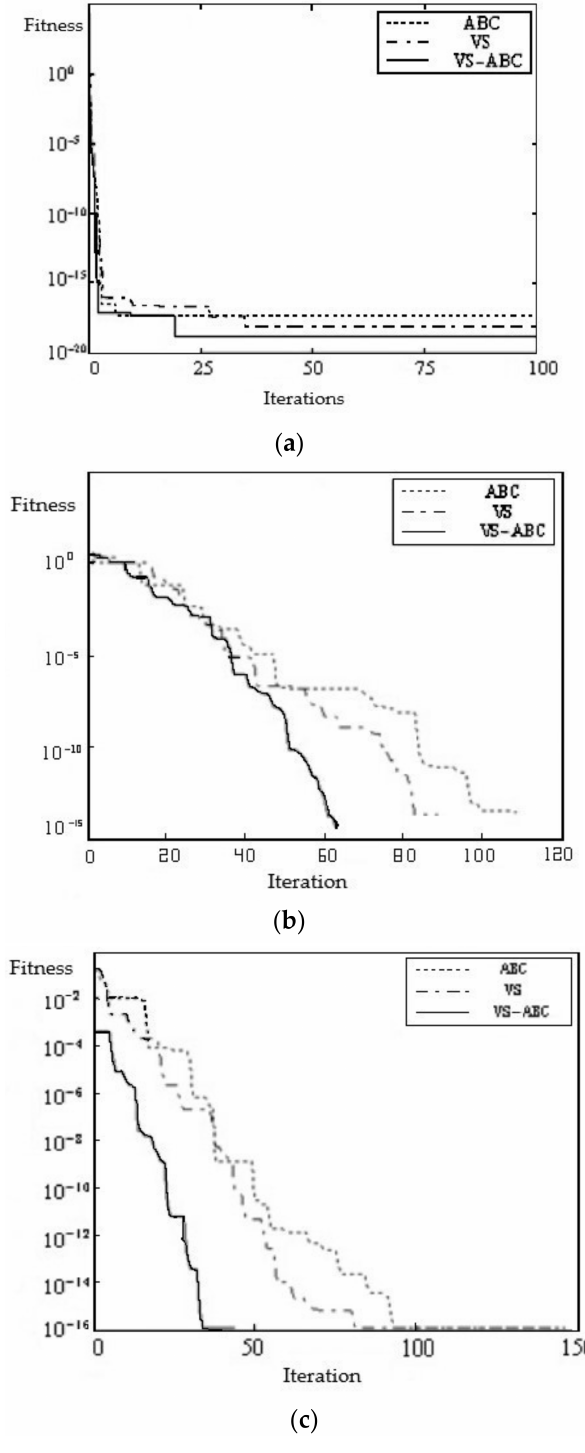
Figure 6. The convergence curve of three functions. ( a ) The convergence curve of Sphere. ( b ) The convergence curve of Rastrigin. ( c ) The convergence of